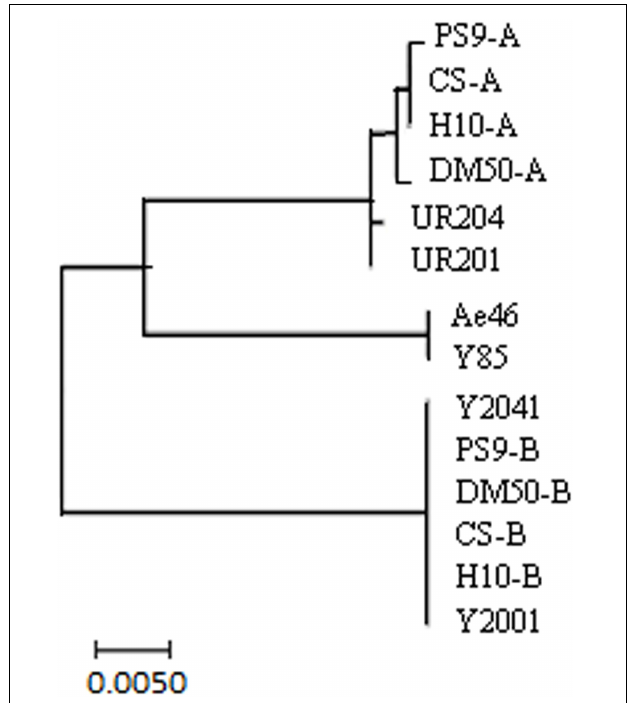
FIGURE 2 | Phylogenetic analyses of TaSnRK2.8 promoters from hexaploid, tetraploid, and diploid wheats. Hexaploid wheat: Chinese Spring (CS) and Hanxuan 10 (H10); tetraploid wheat: PS9 and DM 50; A genome diploid: UR201 and UR204; B genome diploid: Y2001 and Y2041; D genome diploid: Y85 and Ae46. Phylogenetic analysis was conducted in MEGA